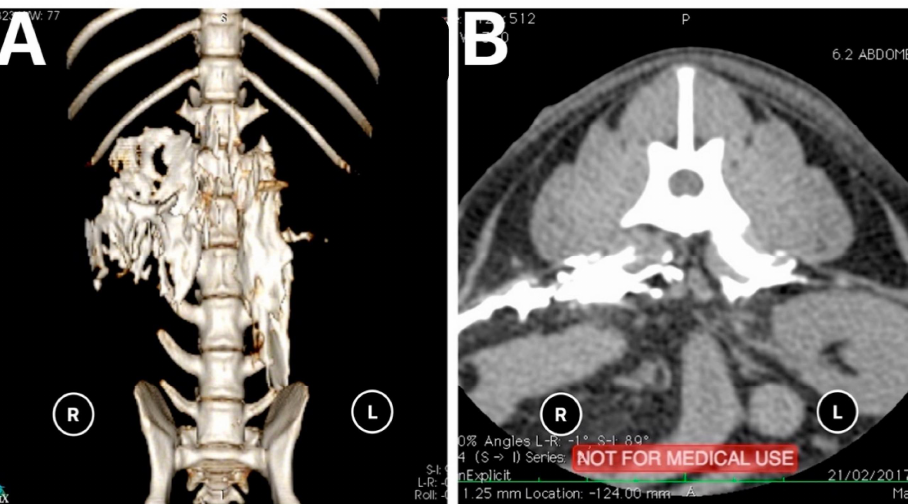
Figure 5. ( A ). 3D CT image of a carcasses showing a combined linear-lateral pattern of distribution of the mixture on the right and linear pattern on the left after performing the quadratus lumborum block. ( B ). Transverse view of CT image showing a lateral pattern on the right and linear pattern on the left.